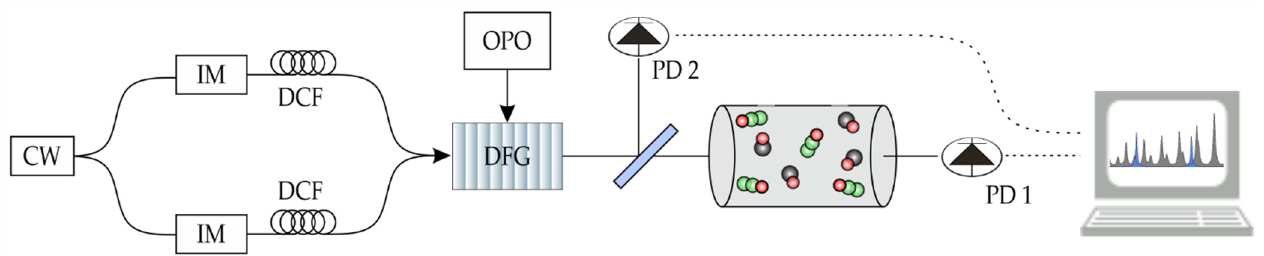
Figure 1. Schematic setup of the spectrometer. The light emitted by a continuous wave laser (CW) is split into two branches and modulated by two intensity modulators (IM) with slightly different repetition rates. The resulting combs are spectrally broadened in dispersion-compensating fibers (DCF), superimposed and converted to the mid-infrared via difference frequency generation (DFG) with an optical-parametric oscillator (OPO) in a periodically poled lithium niobate crystal. The mid-infrared dual comb is divided by a beam splitter and detected with PD 2 before the gas cell and after with PD 1.